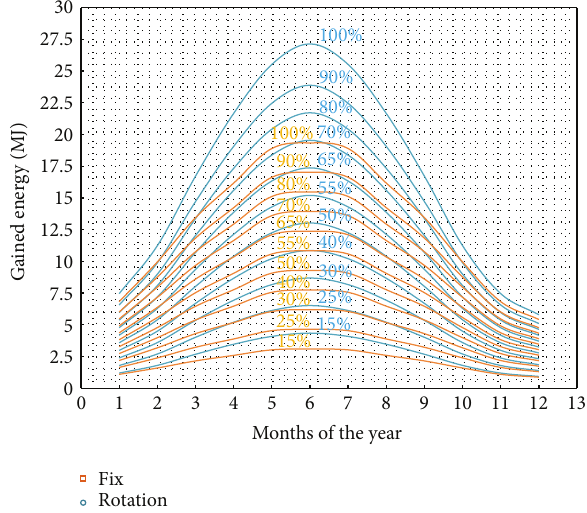
Figure 22: Theoretically determined average monthly values of the gained energy for each month throughout the year for the rotary system and the static system based on the change of a global daily light intensity